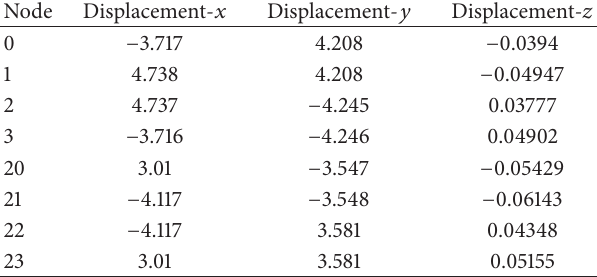
Table 3: The displacements (in m) at green nodes using the linear FEM for the second experiment. The displacements at blue nodes are zero.